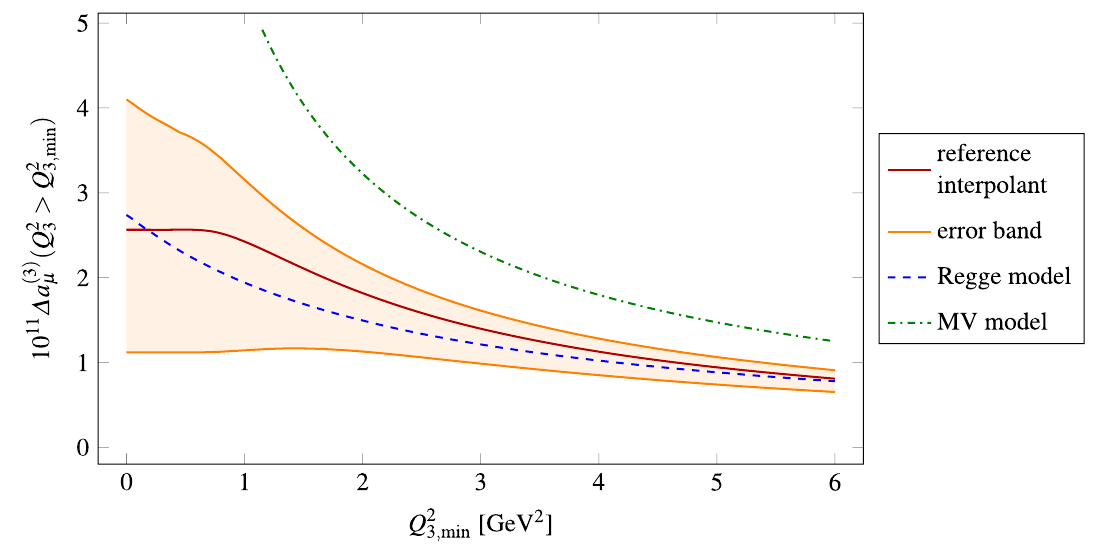
Fig. 5 Δ a ( 3 ) μ as a function of a lower limit on Q 2 erence result and corresponding error band against the tower of excited pseudoscalars in the large- N c Regge model 1 of Refs. [32,33] and the curve from the MV model [25] evaluated using the up-to-date disper- sive pion TFF. At small non-vanishing Q 2